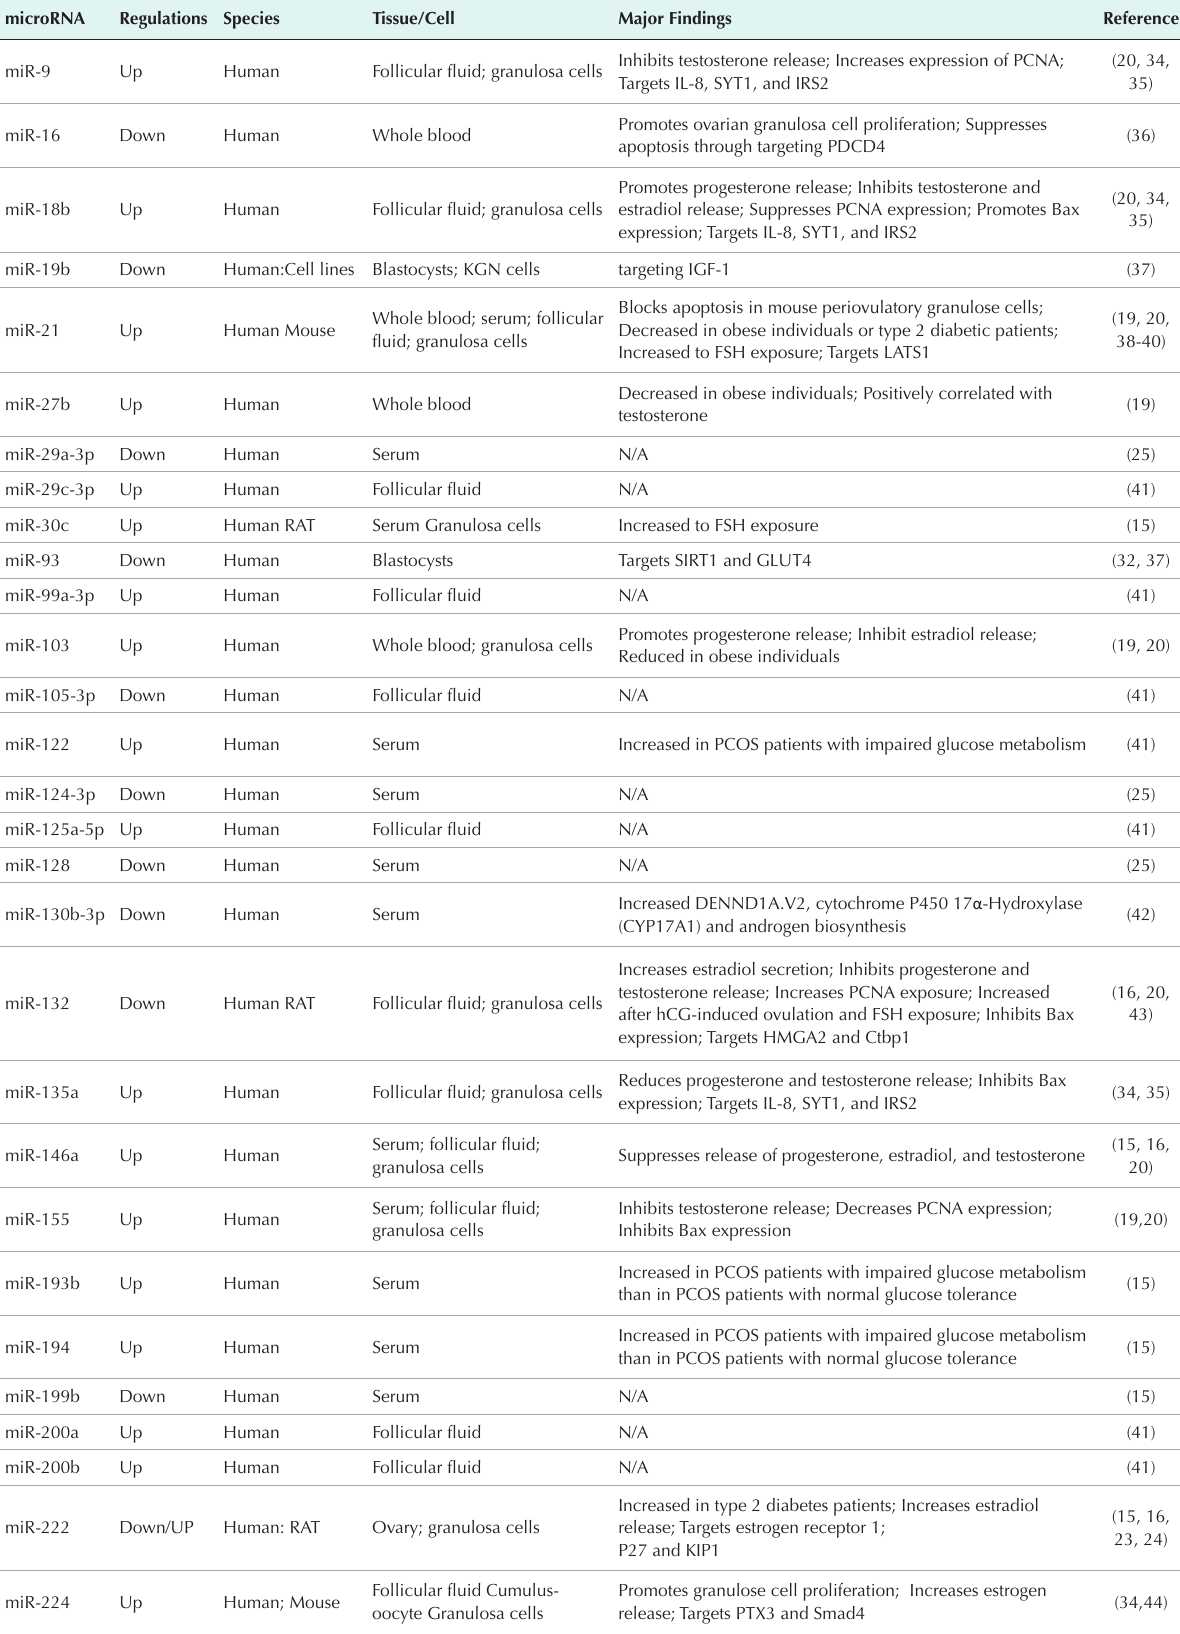
Table 1. The Studied microRNAs in PCOS